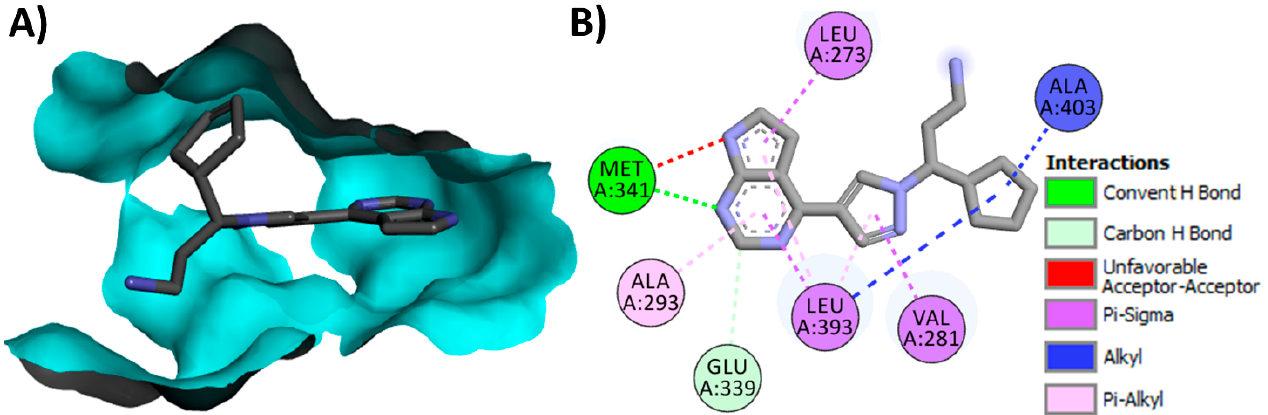
Figure 55. Binding modes of ruxolitinib (shown as sticks) into c-Src (pdb: 4U5J): ( A ) 3D binding mode, receptor shown as a hydrogen bond surface; ( B ) 2D binding mode showing different types of interactions with c-Src; hydrogen atoms were omitted for clarity; this figure was generated using Discovery Studio Visualizer (V16.1.0.15350).